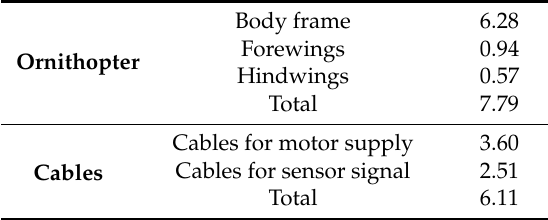
Table 2. Weight composition of the ornithopter in grams.